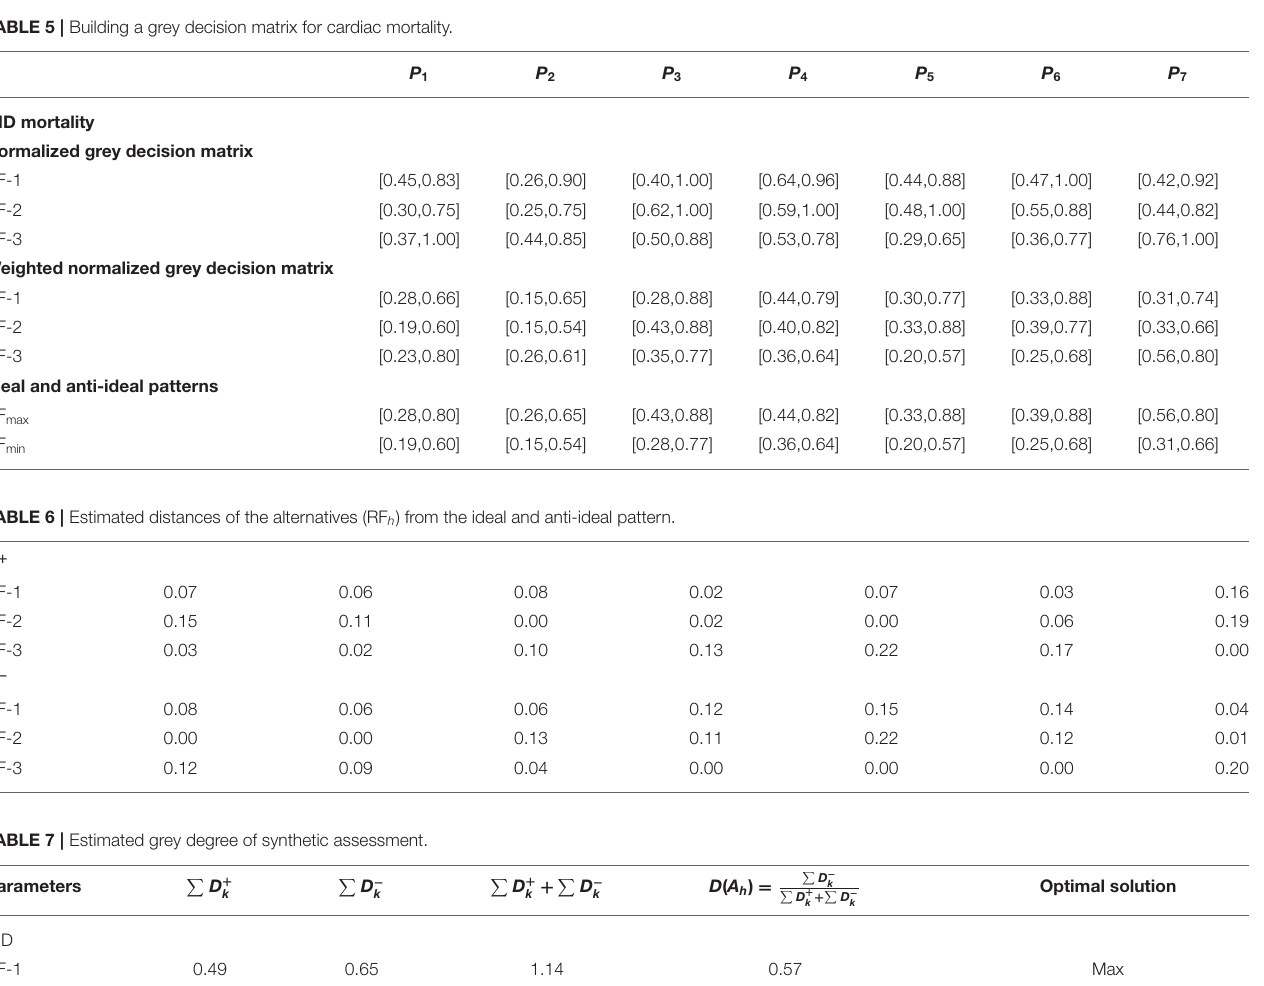
TABLE 5 | Building a grey decision matrix for cardiac mortality.